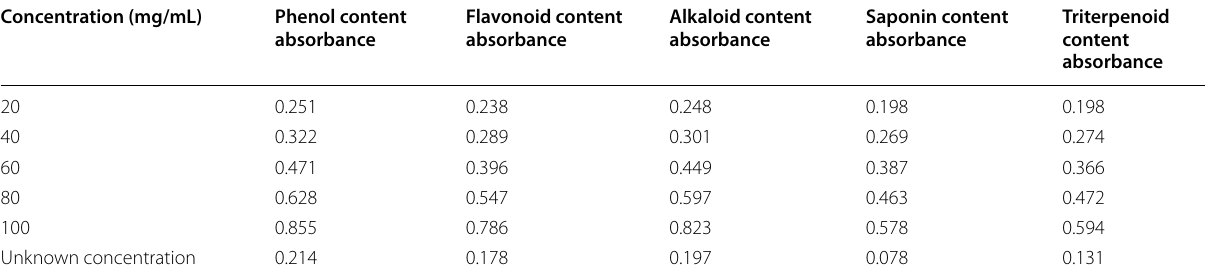
Flavonoid content absorbance